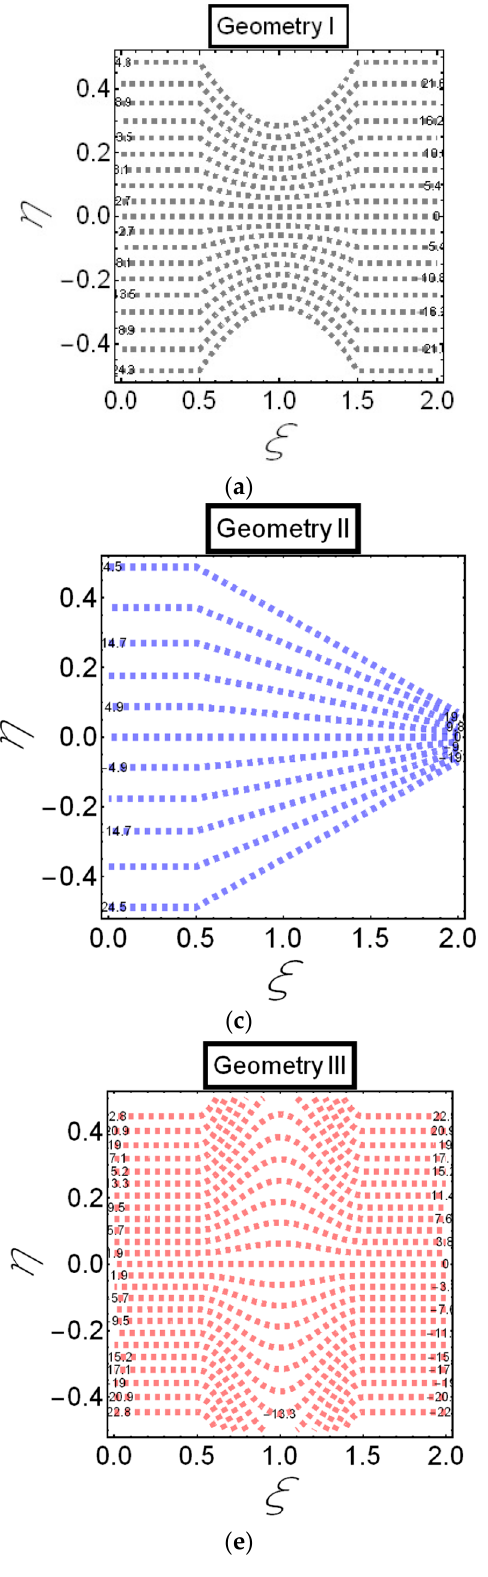
Figure 15. Streamlines for 𝛽 (cid:2869) = 0.5 ( a , c , e ) and 𝛽 (cid:2869) = 2 ( b , d , f ).